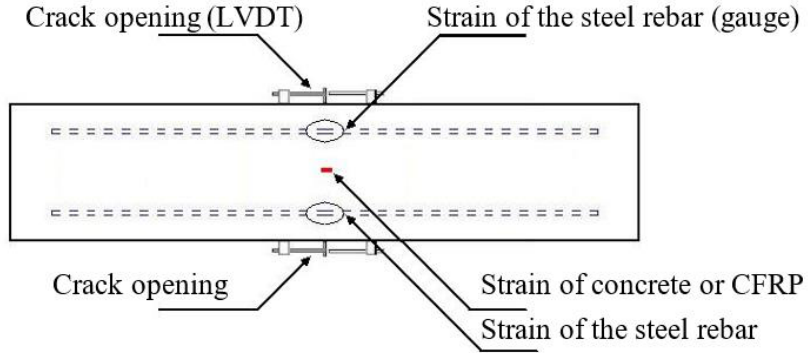
Figure 4. Instrumentation layout of the soffit of a beam (under